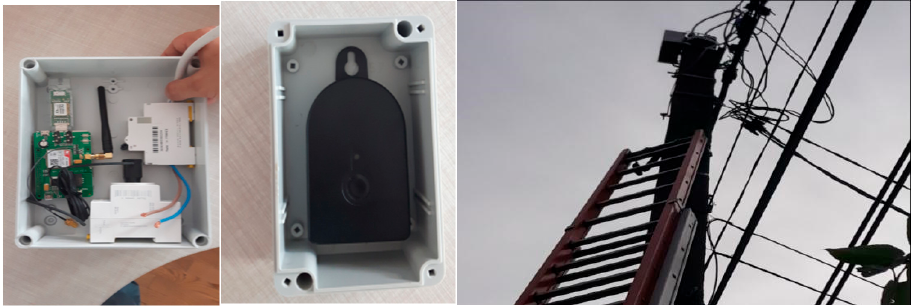
Figure 3. The pilot device assembly ( left ) and the mounting ( right ). The mounting was carried out by the beneficiary partner within the